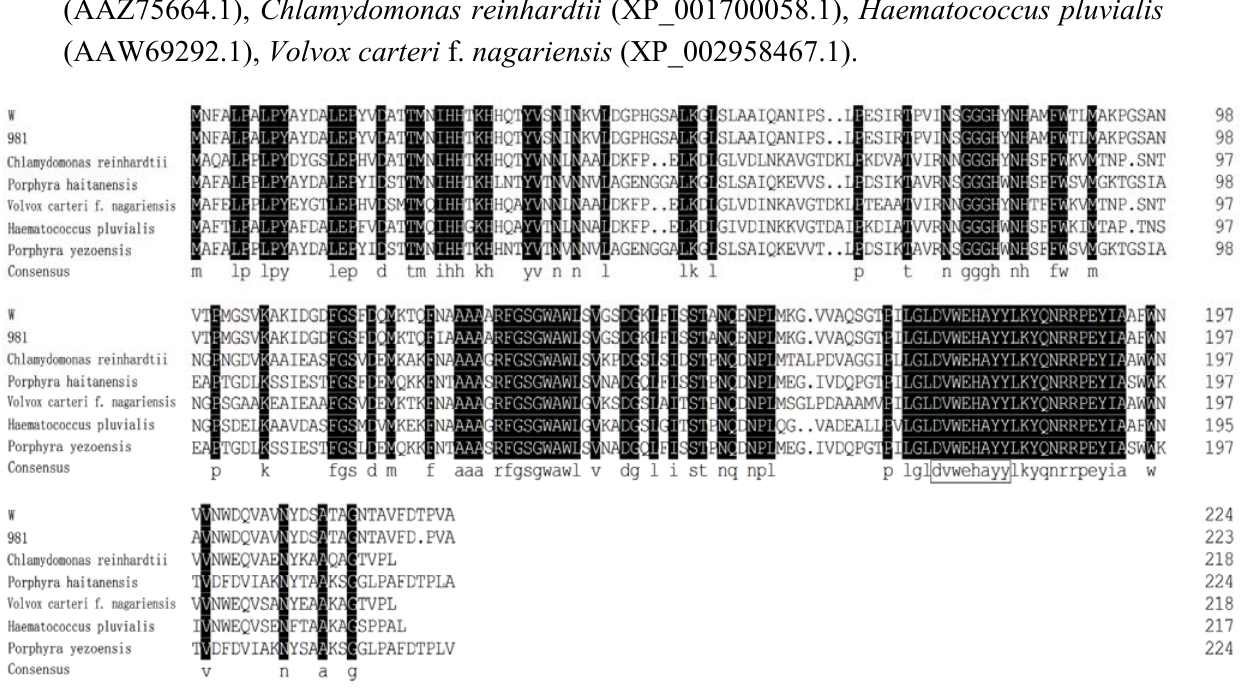
Figure 2. Alignment of Mn-SOD amino acid sequences of G. lemaneiformis and other